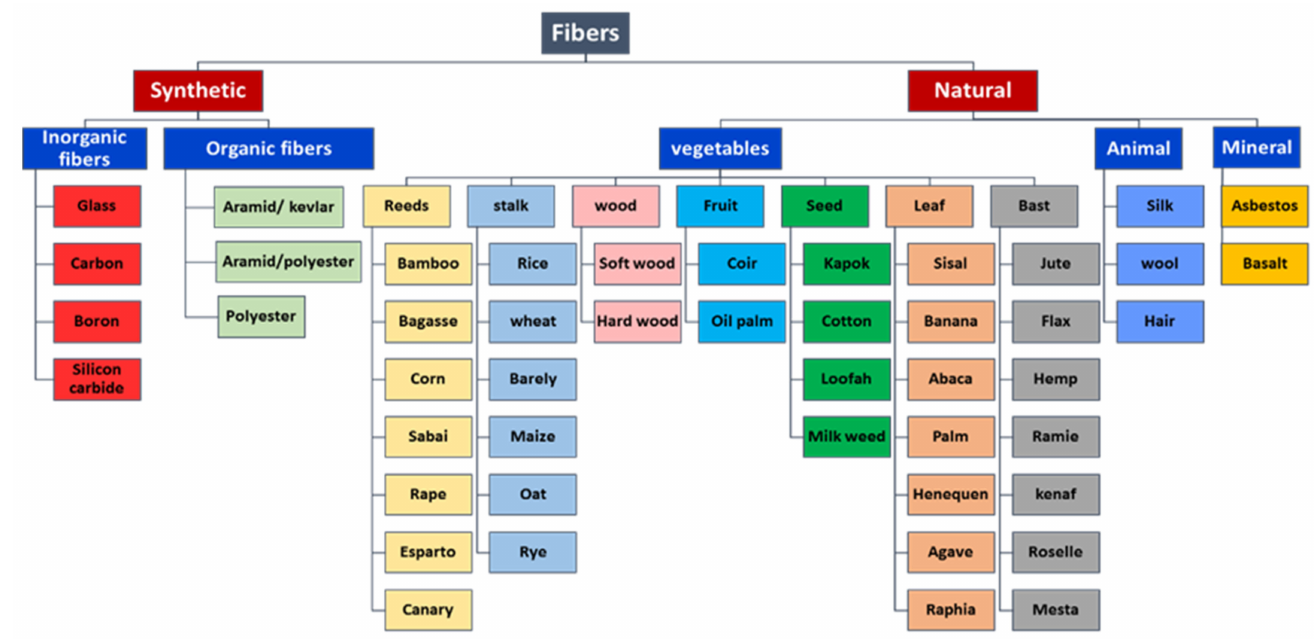
Figure 1. Different categories of fibers for FRP composite